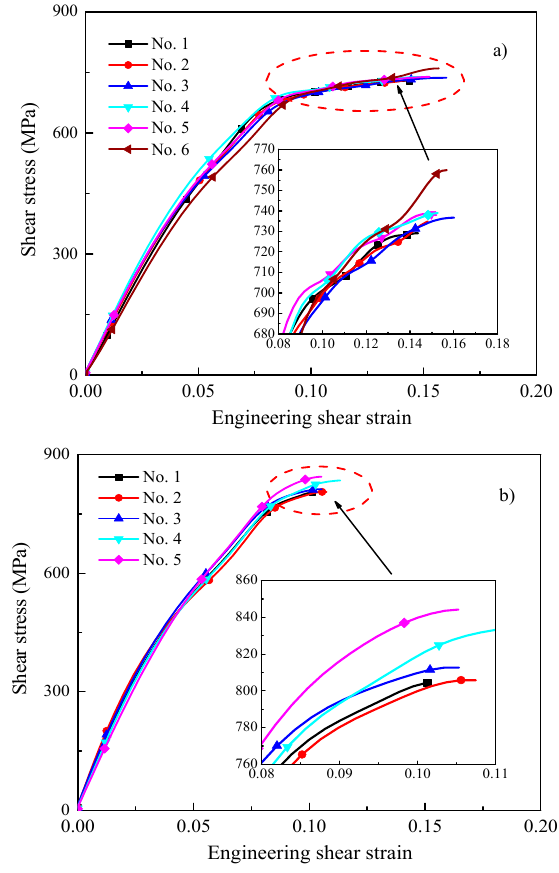
Figure 11. Plot of shear stress as a function of nominal shear strain for ( a ) Ti-64 alloy; and ( b ) Ti-55511 alloy. Table 4. Calculation of dynamic failure energy of FHS